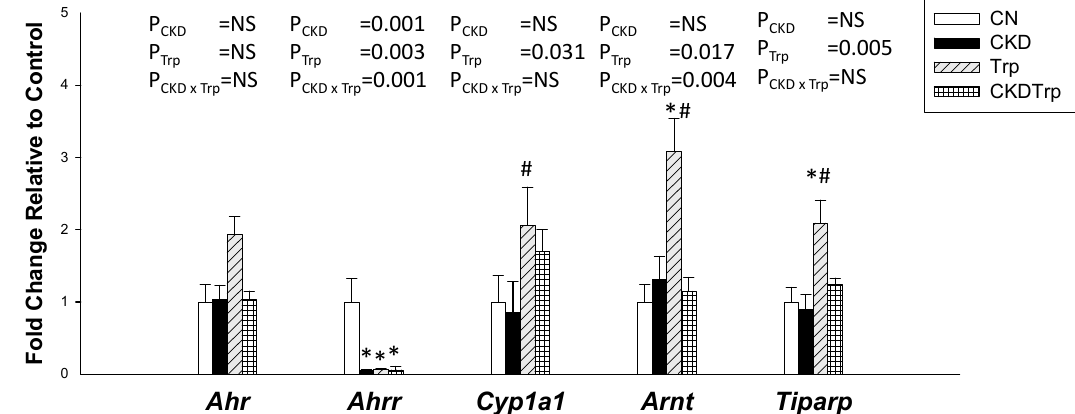
Figure 2. Effects of maternal adenine-induced chronic kidney disease (CKD) and tryptophan supplementation (Trp) on aryl hydrocarbon receptor (AHR) pathway in offspring kidneys at 12 weeks of age. Data are shown as means ± S.E.M. A two-way ANOVA with a Tukey’s post hoc test was performed for statistical analysis. CKD × Trp = interaction of CKD and Trp. * p < 0.05 vs. CN. # p < 0.05 vs. CKD. n = 8/group.